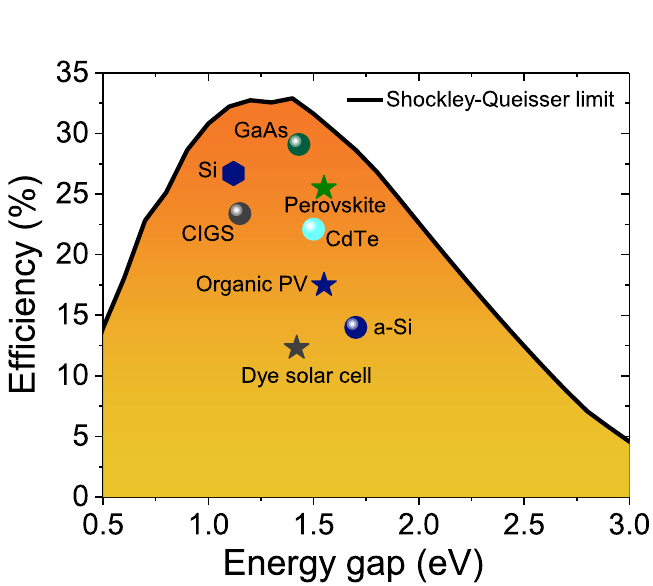
Fig. 8. – Theoretical Shockley-Queisser efficiency limit as a function of the bandgap (black line) [12]. The record efficiencies for different absorber materials are plotted for the correspond- ing bandgaps. Hexagons symbols are related to crystalline materials, circles to thin-film PV while stars to emerging